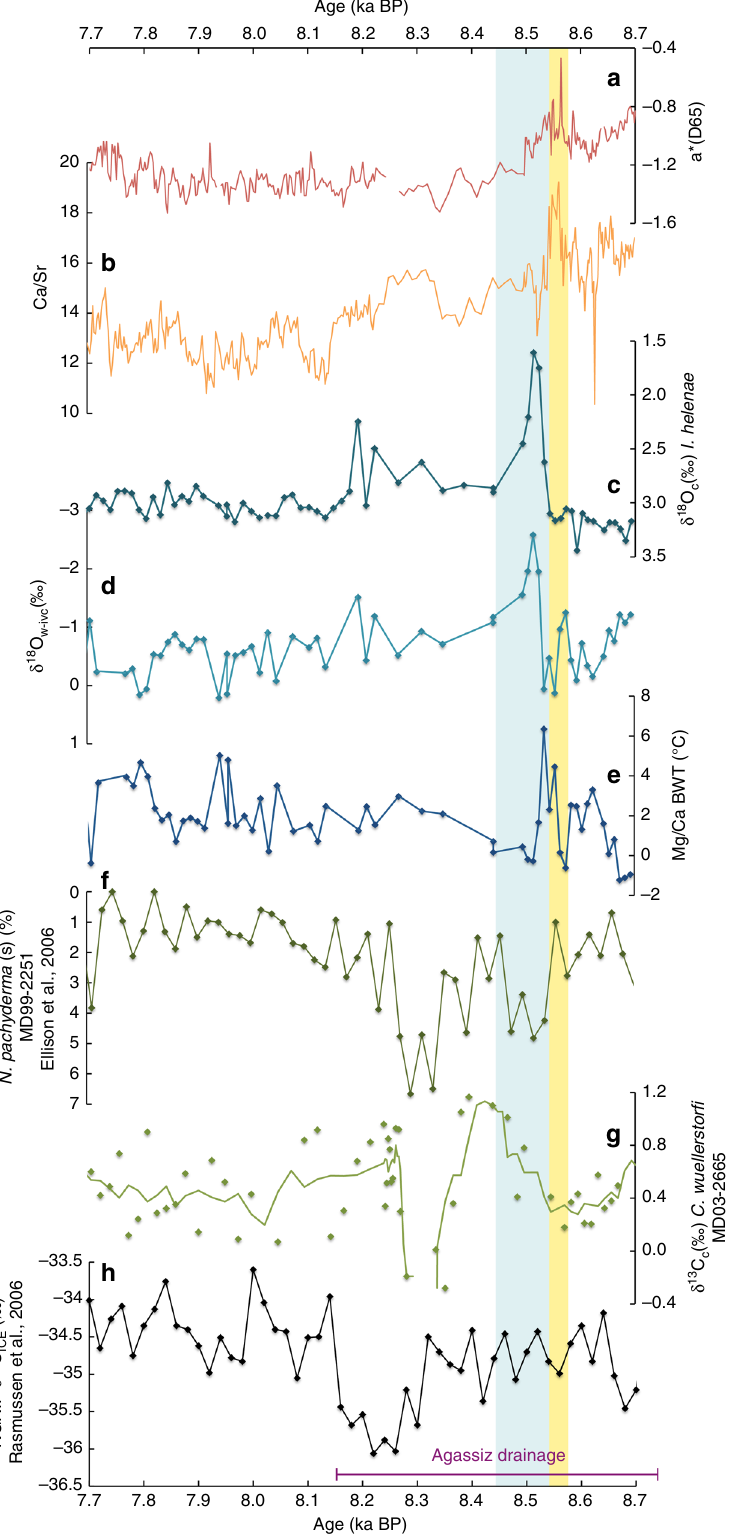
Fig. 4 Effects of the freshwater pulse on North Atlantic circulation and temperature. Early Holocene high-resolution records of core MSM45-19-2 ( a – e ) are compared with Atlantic Meridional Overturning Circulation records of MD99-2251 7 ( f ) and MD03-2665 8 ( g ) as well as the atmospheric temperature record in NGRIP 4 – 6 ( h ). Also shown is the age of the Agassiz drainage event with 1 σ uncertainties (8.16 – 8.74 ka before present) 9 denoted by a purple line. The yellow vertical bar marks the initial Lake Agassiz-Ojibway outburst, while the blue bar marks the Hudson Bay Ice Saddle